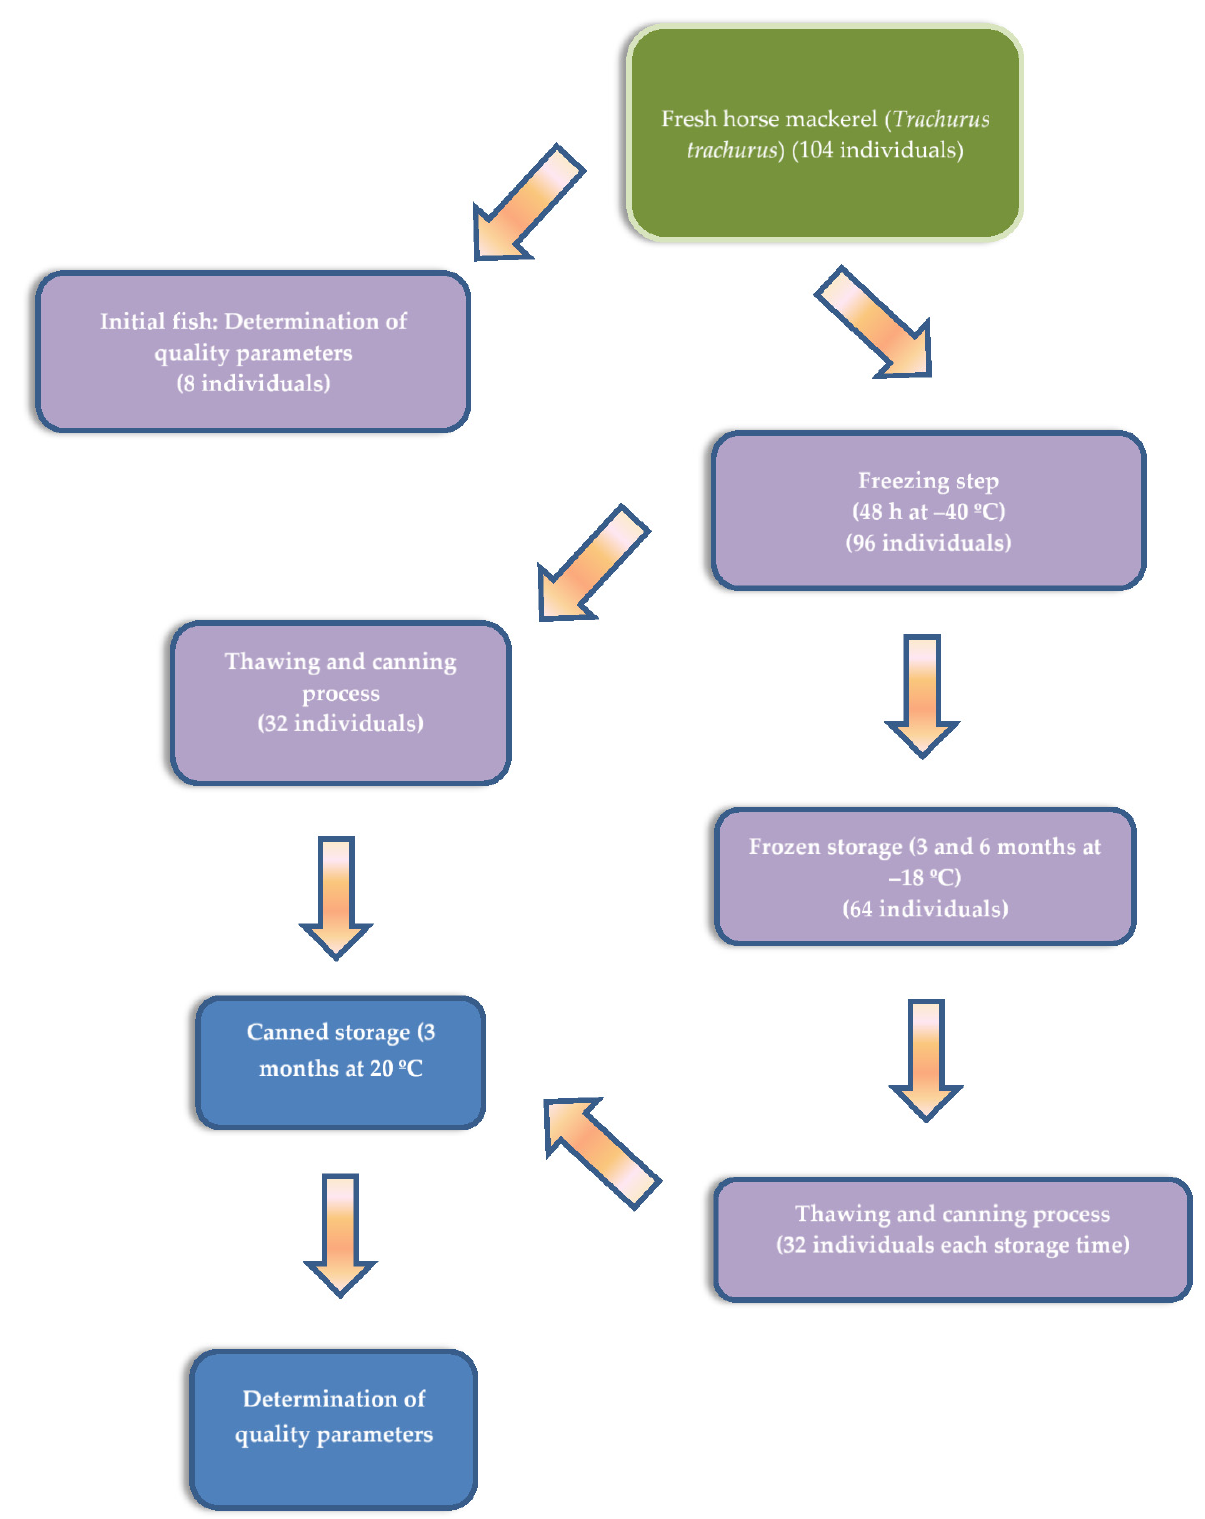
Figure 1. Summarised steps carried out in the present experimental